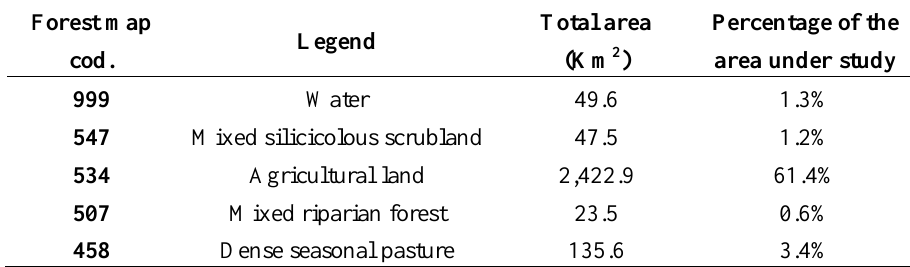
Table 2. Forest categories of area under